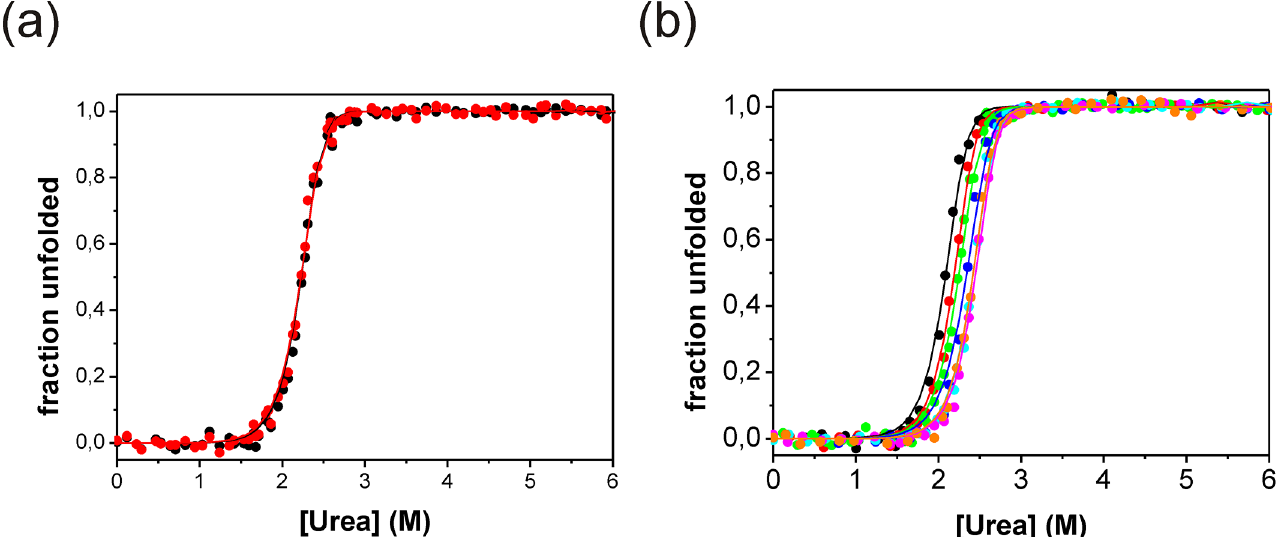
Fig 2. Urea induced equilibrium unfolding transitions of N-BAR. (a) The black symbols represented fluorescence (327 nm) and red symbols circular dichroismn (222 nm) measurements. The transition curves were measured with 1 μ M protein in 20 mM Na phosphate, 100 mM Na chloride, pH 7.4 at 15°C. All curves were fitted to a two-state model for dimeric proteins. (b) Fluorescence detected urea transition curves of N-BAR at different protein concentrations: black circle 0.1 μ M, red circle 0.5 μ M, green circle 1 μ M, dark blue circle 2.5 μ M, light blue circle 5 μ M, magenta circle 10 μ M and orange circle 25 μ M. The